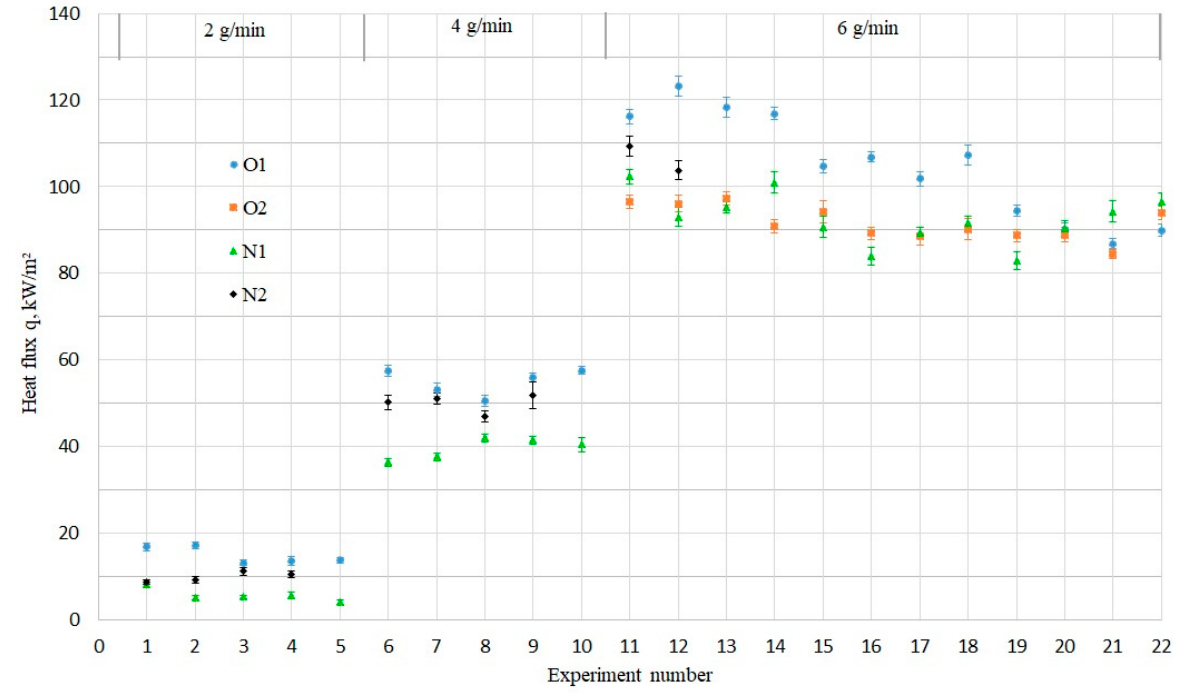
Figure 3. Condensation heat flux for each experiment for the investigated samples.